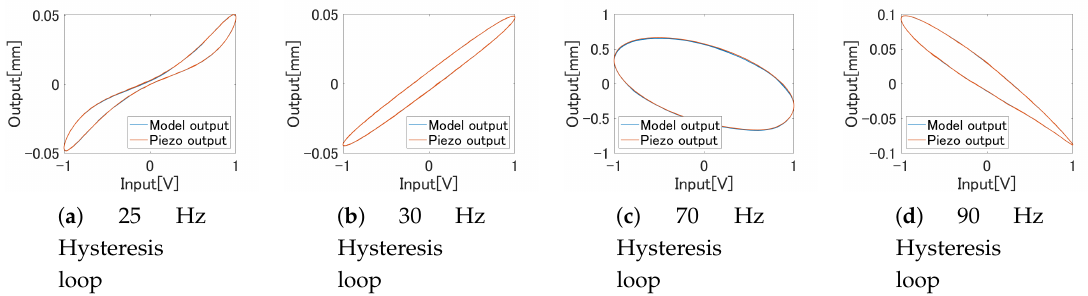
Figure 15. The simulation results of the proposed identified model for four different input